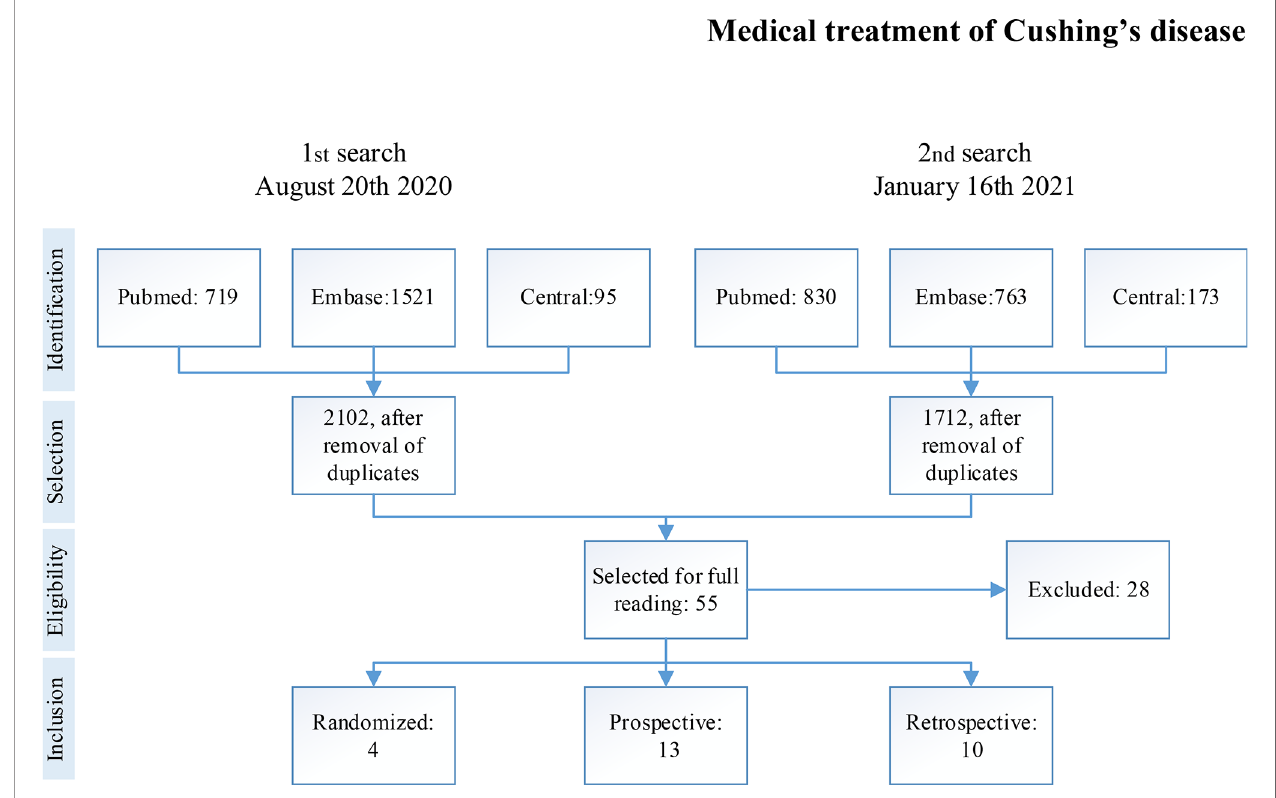
FIGURE 1 | Process of selection of